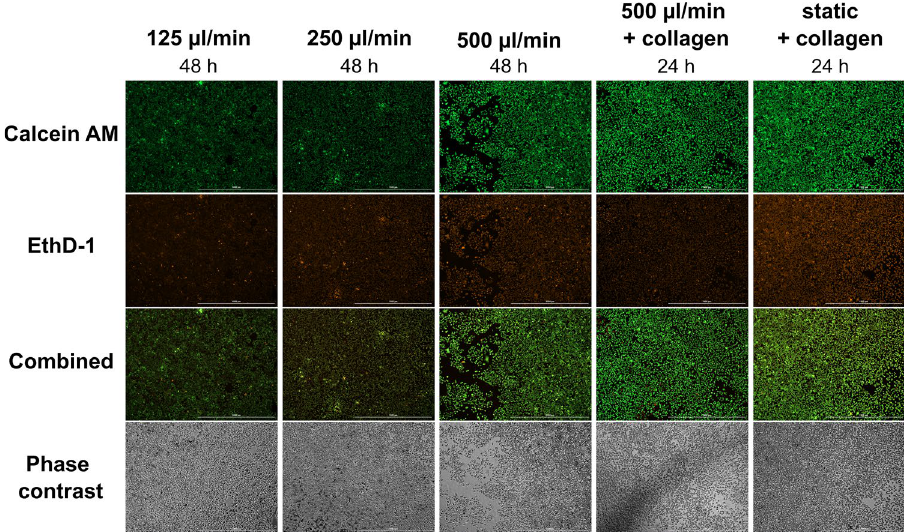
Figure 4. The viability of A549 cells under 125, 250, and 500 µl/min, when the cells were let to attach either onto glass coverslip for 48 h or onto collagen coated coverslip for 24 h. The cells were stained with Live/Dead viability/cytotoxicity assay. Calcein AM (green) shows alive cells and EthD-1 (ethidium homodimer-1) (orange) shows dead cells (X4, scale bar shows 1000